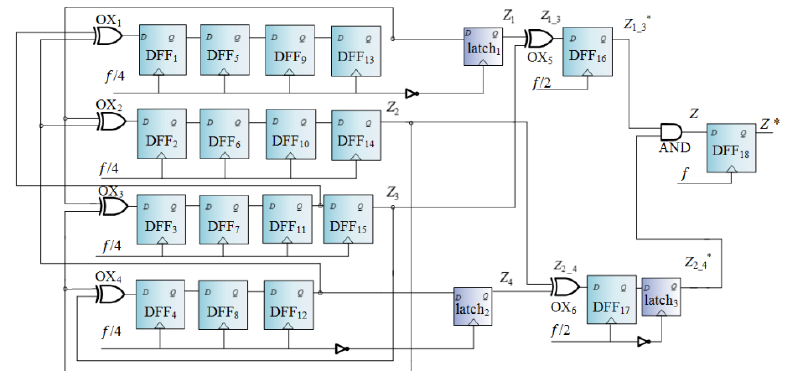
Figure 7. Matrix generation module.